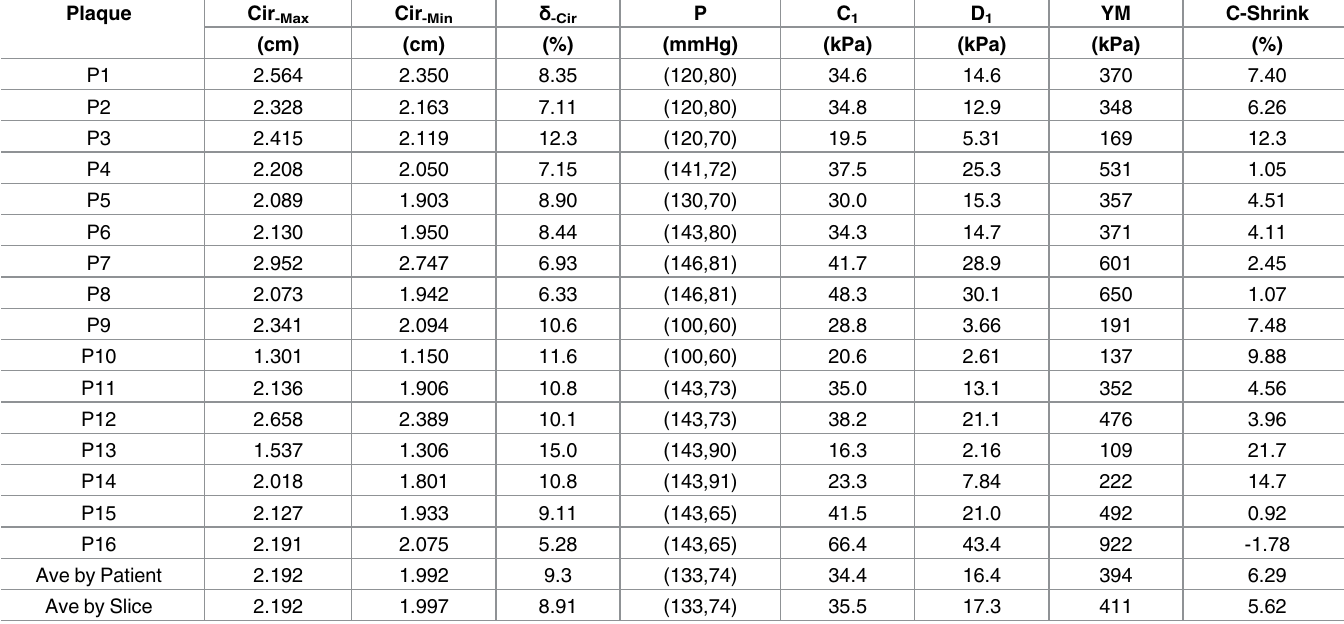
Table 3. Averagematerial parameter values and circumferential shrinkage for 16 human carotid plaque samples based on Cine MRI data. Due to axial shrink appliedto the 3D thin-layermodel, some C-Shrink values in 3D thin-layer model were